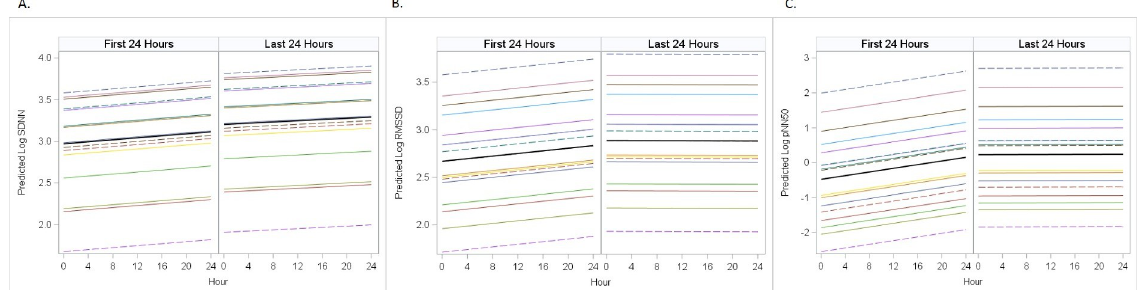
Fig 3. Mixed effects model demonstrating predicted average log heart rate variability in the first vs. last 24 hours of PICU stay. The predicted log HRV is demonstrated for each patient (colored lines) as well as the average value (solid black line) in the first 24 hours of PICU admission (left panel) vs. last 24 hours (right panel). Each colored line indicates an individual patient’s conditional predicted HRV accounting for random effects with the solid black line representing the marginal predicted mean accounting only for fixed effects. Hour represents the number of hours that have passed after admission (left panel) or number of hours that have passed in the 24 hours prior to discharge (right panel). Hour 0 in the first period is the first measurement upon admission; hour 0 in last period is 24 hours before discharge. Mixed models demonstrated that all three measures of HRV were significantly lower during the first 24 hours compared to the last 24 hours of PICU admission (p <